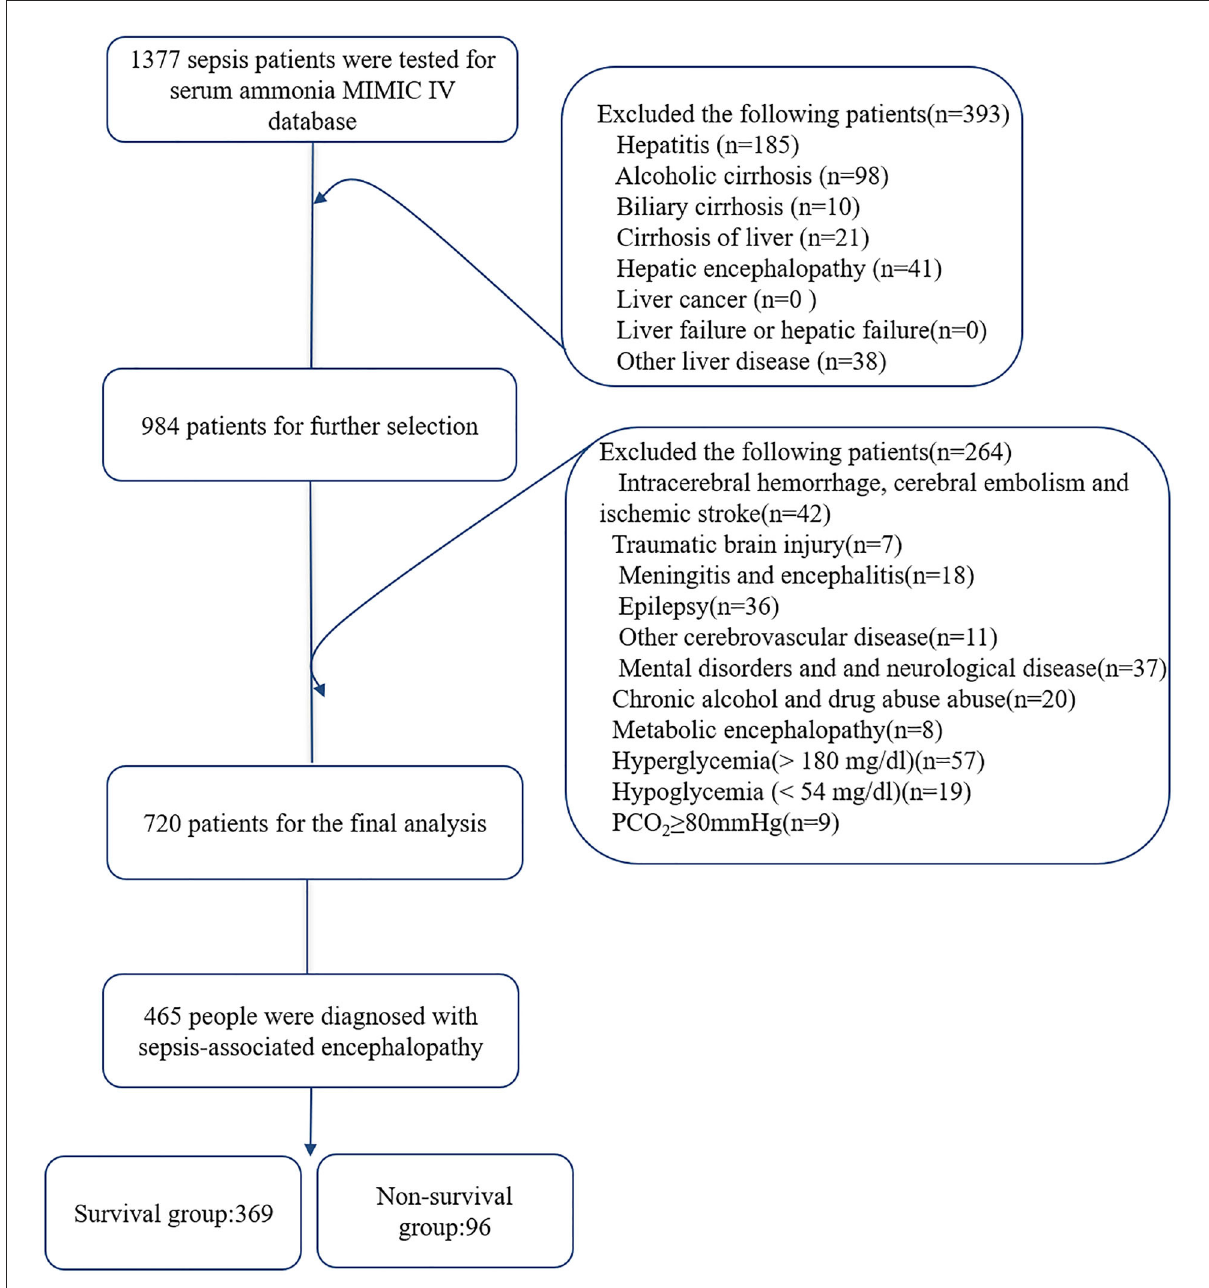
FIGURE1 Flowchart of patient selection. MIMIC-IV, Medical Information Mart for Intensive Care